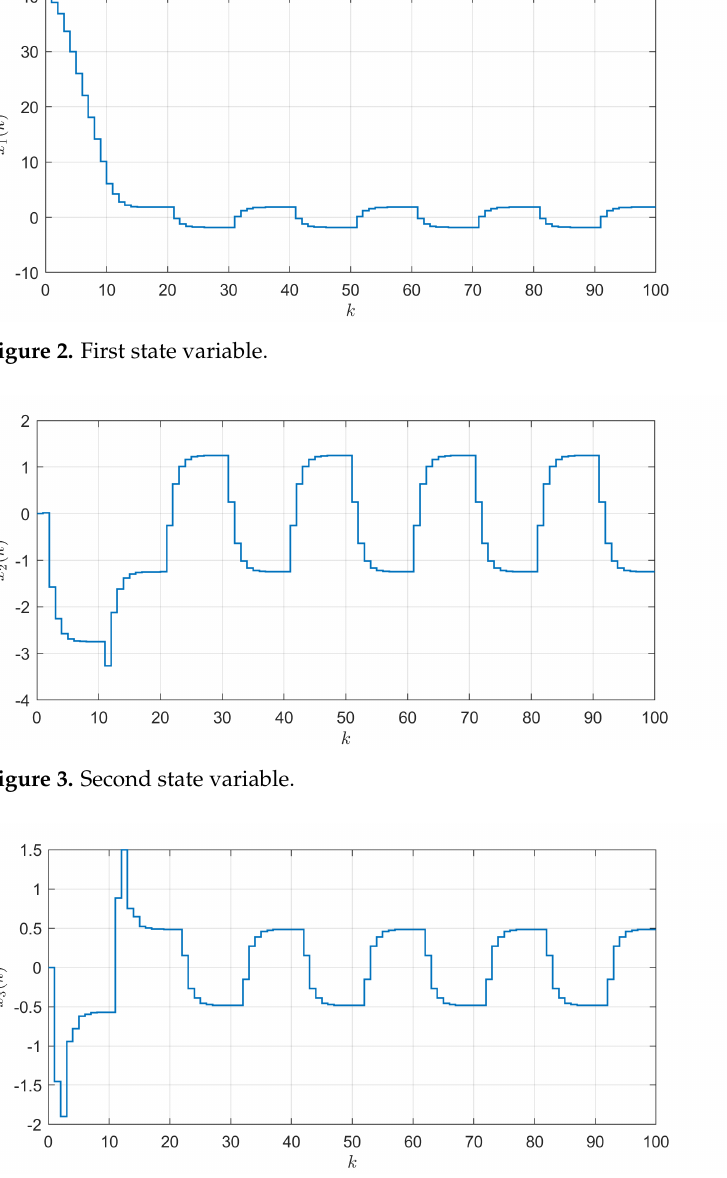
Figure 4. Third state variable.